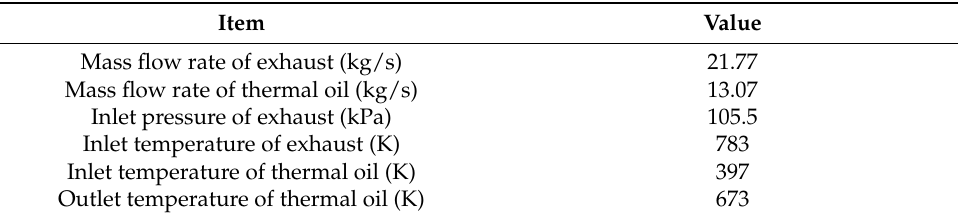
Table 1. Thermodynamic conditions for plate-fin heat exchanger inlet and